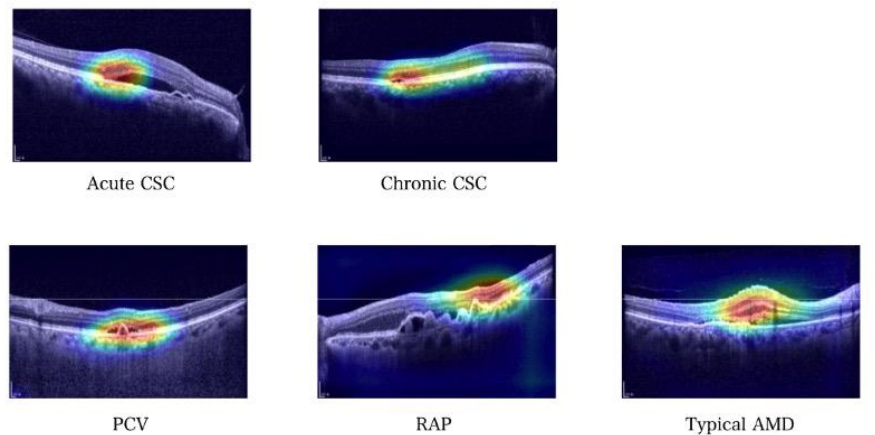
Figure 5. Grad–CAM visualization of five cases of nAMD and CSC subtypes. The high-intensity area (red and yellow color) reflects the area of interest in our model. The corresponding Grad–CAM image shows that our model focused on similar clinical criteria for classifying nAMD and CSC sub- types.